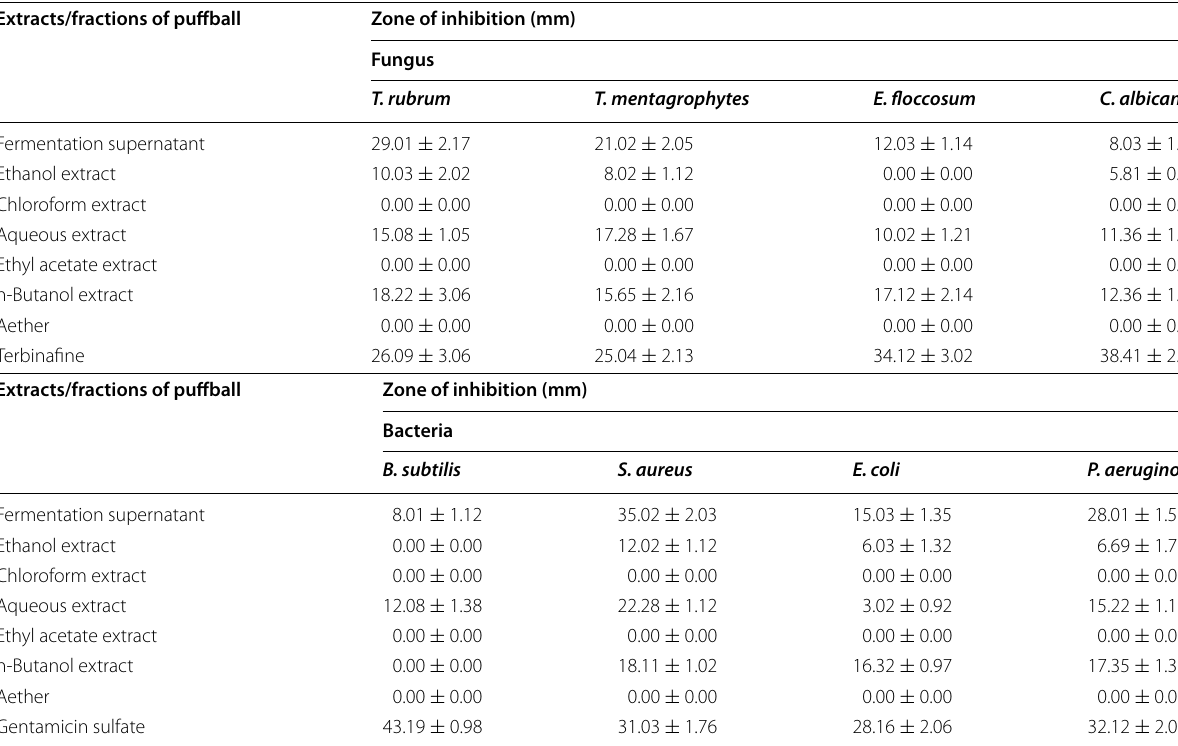
The date are mean